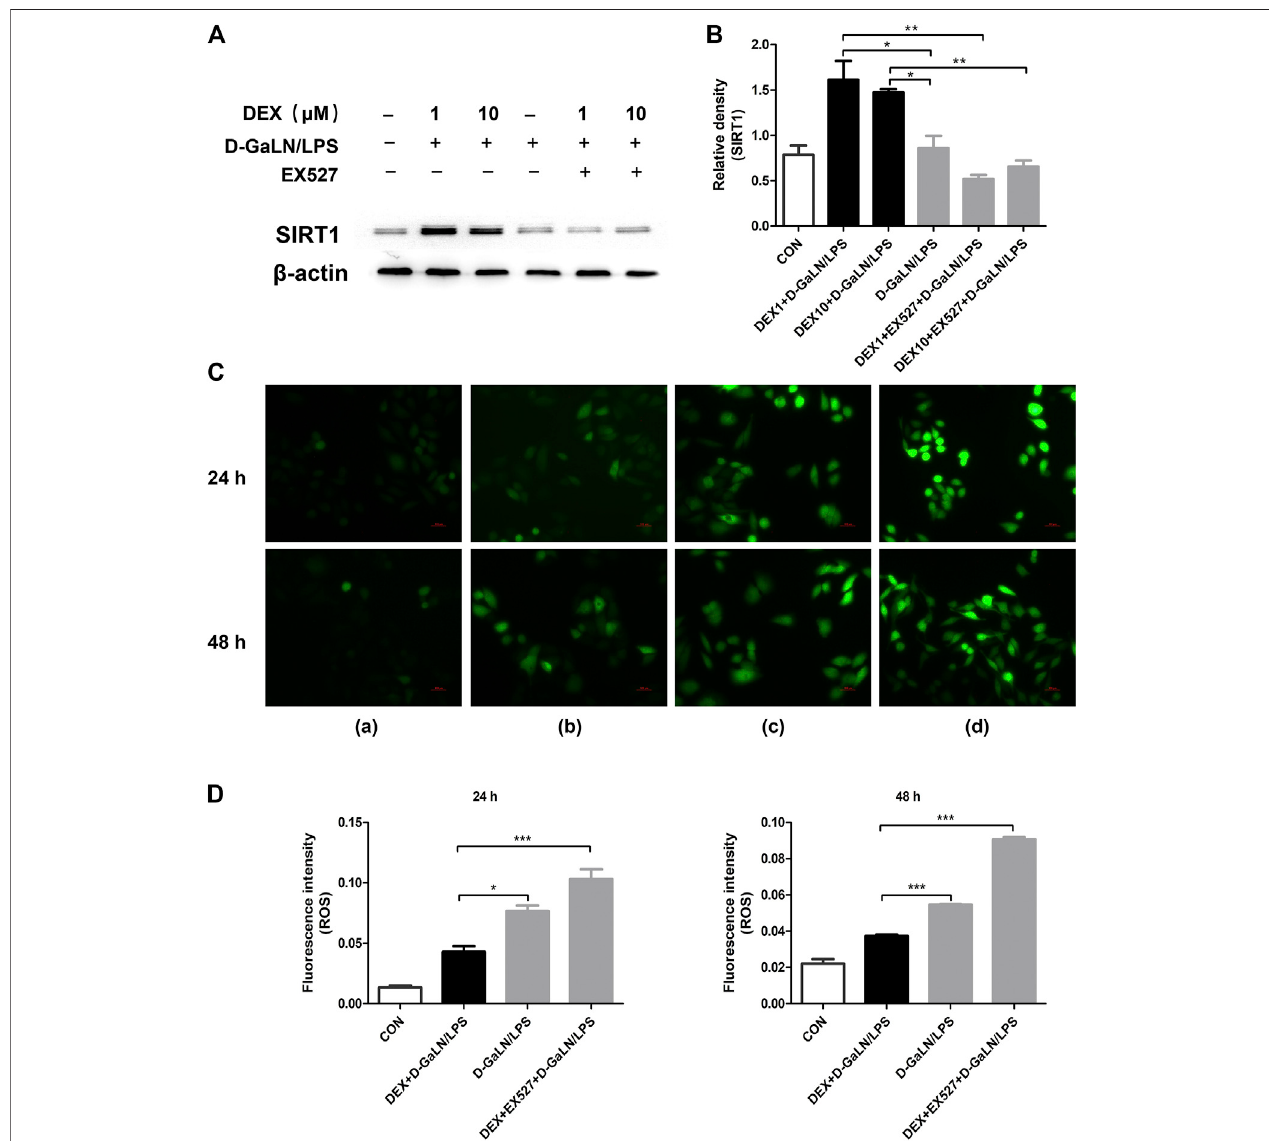
FIGURE 6 | DEX reduced D-GalN/LPS-induced ROSproduction could reversed by EX527. (A) The protein expression of SIRT1 in L-02 cells, asdetermined using westernblotting. (B) DensitometricanalysisofSIRT1from (A) . (C) IntracellularROSleveldetermination. (C) andthequantitativeresults (D) .(A):Controlgroup;(B):DEX+ D-GalN/LPSgroup(DEX:1 μ M,D-GalN:10 mM,LPS:10 ng/ml);(C):D-GalN/LPSgroup(D-GalN:10 mM,LPS:10 ng/ml);(D):DEX+EX527+D-GalN/LPSgroup(DEX: 1 μ M, EX527: 10 μ M, D-GalN: 10 mM, LPS: 10 ng/ml). Error bars on the bar graphs represent the mean ± SD. * p < 0.05, ** p < 0.01, *** p < 0.001.